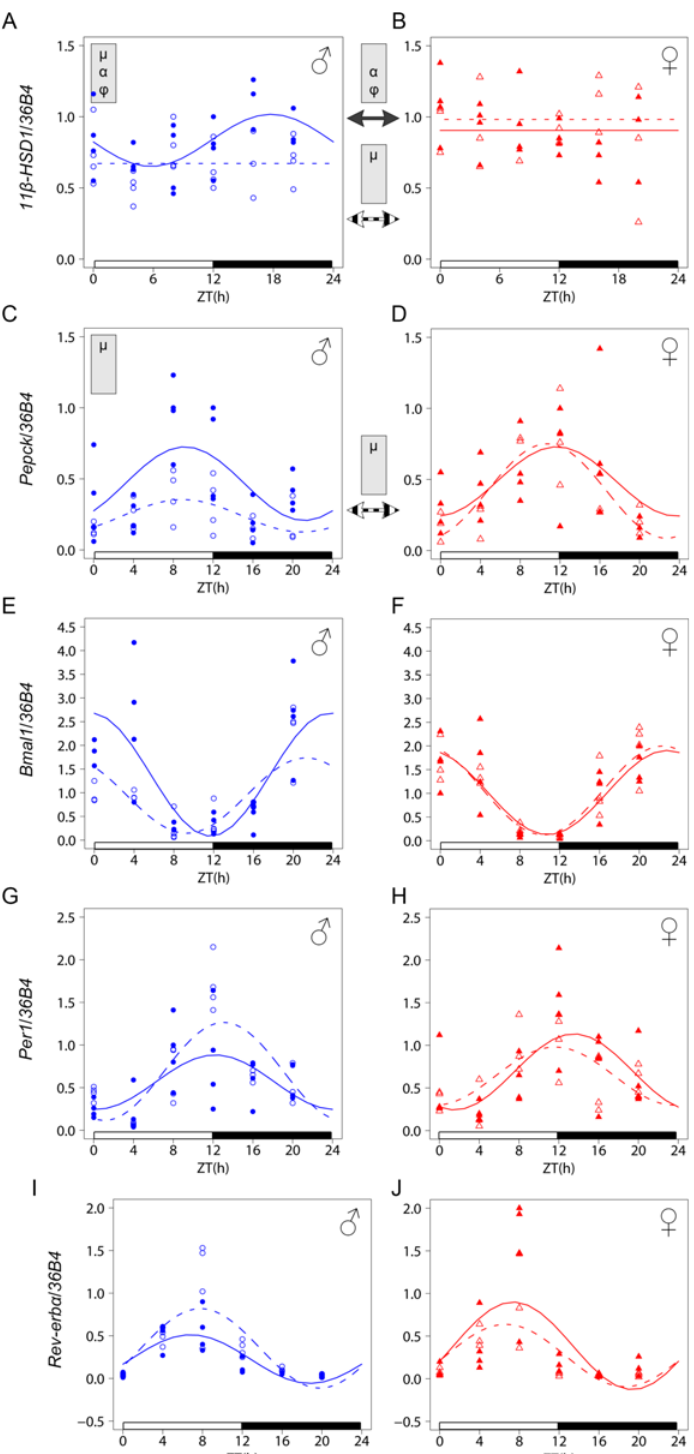
Fig 5. Analysis of circadian gene expression in the liver of WT and Lxr α -/- mice . Diurnal mRNA expression of liver 11 β -HSD1 (A, B), Pepck (C, D), Bmal1 (E, F), Per1 (G, H) and Rev-erb α (I, J) was compared using qRT-PCR in WT (plain line) and Lxr α -/- mice (dashed line). For each time point, 3 – 4 mice were used. Cosinor-based non-linear regression was used for curve fitting. The ZT0 time point is double plotted for visualization purpose. Expression data were normalized to the constitutively expressed 36B4